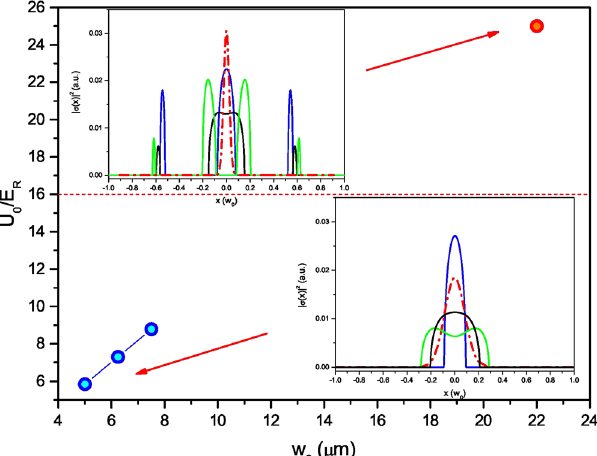
Figure 6. The main parameters of the quasi-Bragg splitter (trap depth and beam waist) are shown for different realizations numerically optimized to minimize the generation of radial excitations when dividing the cloud into two equal parts. Solving the relative Mathieu equations, we observe a crossover from a single isolated spatial gap appearing at the centre of the crossing region ( w 0 ≤ 8 μ m, shown with blue dots in the graph) to two distinct gaps (red dot refers to our experimental realization). The dashed line is a simple estimate of the upper boundary for an isolated band gap to appear, calculated in the limit  U E . In the insets we report the section t R of the spatial band gaps σ x ( ) 2 for the optimized splitters with w 0 = 5 μ m and w 0 = 22 μ m. For w 0 = 5 μ m the spatial gap has been calculated for three different initial velocities v = (3.94, 4.04, 4.14)v R with spread δ v = 0.2v R (solid lines in the inset) and for maximum lattice amplitude 22 E R . For w 0 = 22 μ m, the calculation has been done for ε = v = (7.90, 8.00, 8.10)v R with maximum lattice amplitude of 100 E R . The dash-dotted lines show, for comparison, the density distribution of the radial ground state in